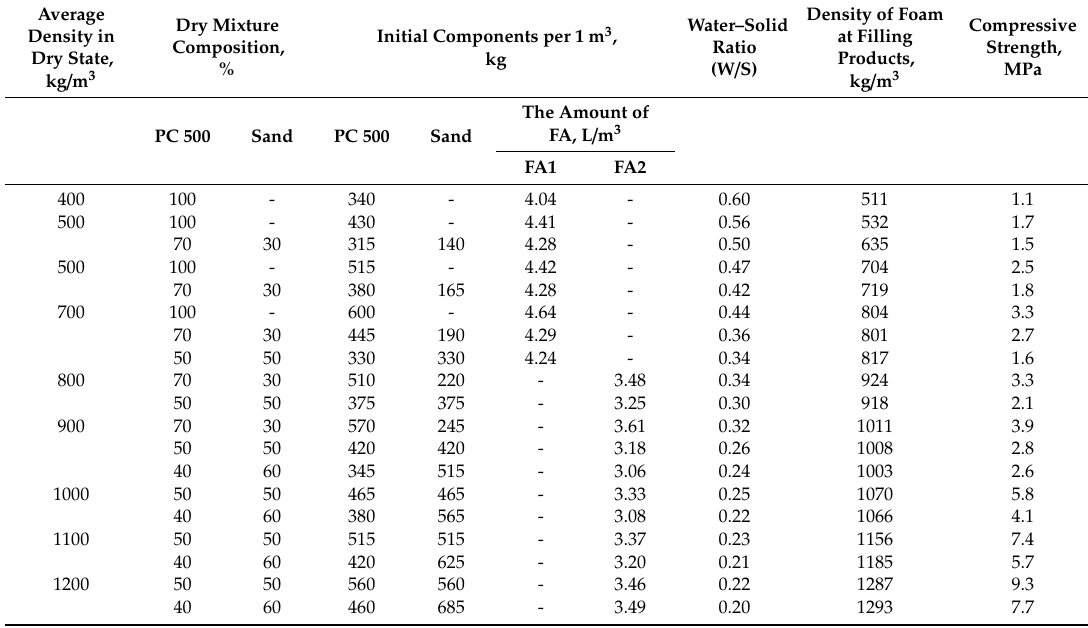
Table 1. Foam concrete compositions of various densities. PC, Portland cement; FA, foaming agent. Average Density in